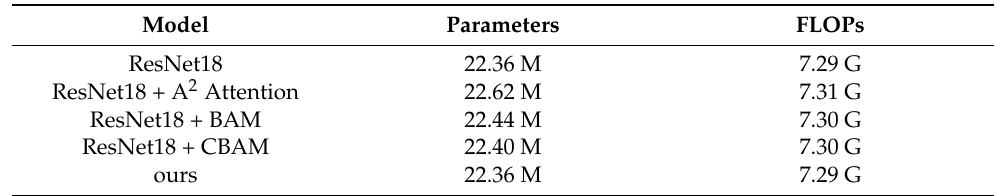
Table 3. Comparison of the complexity of DCDAH with other mainstream models in terms of network parameters and floating-point operations per second